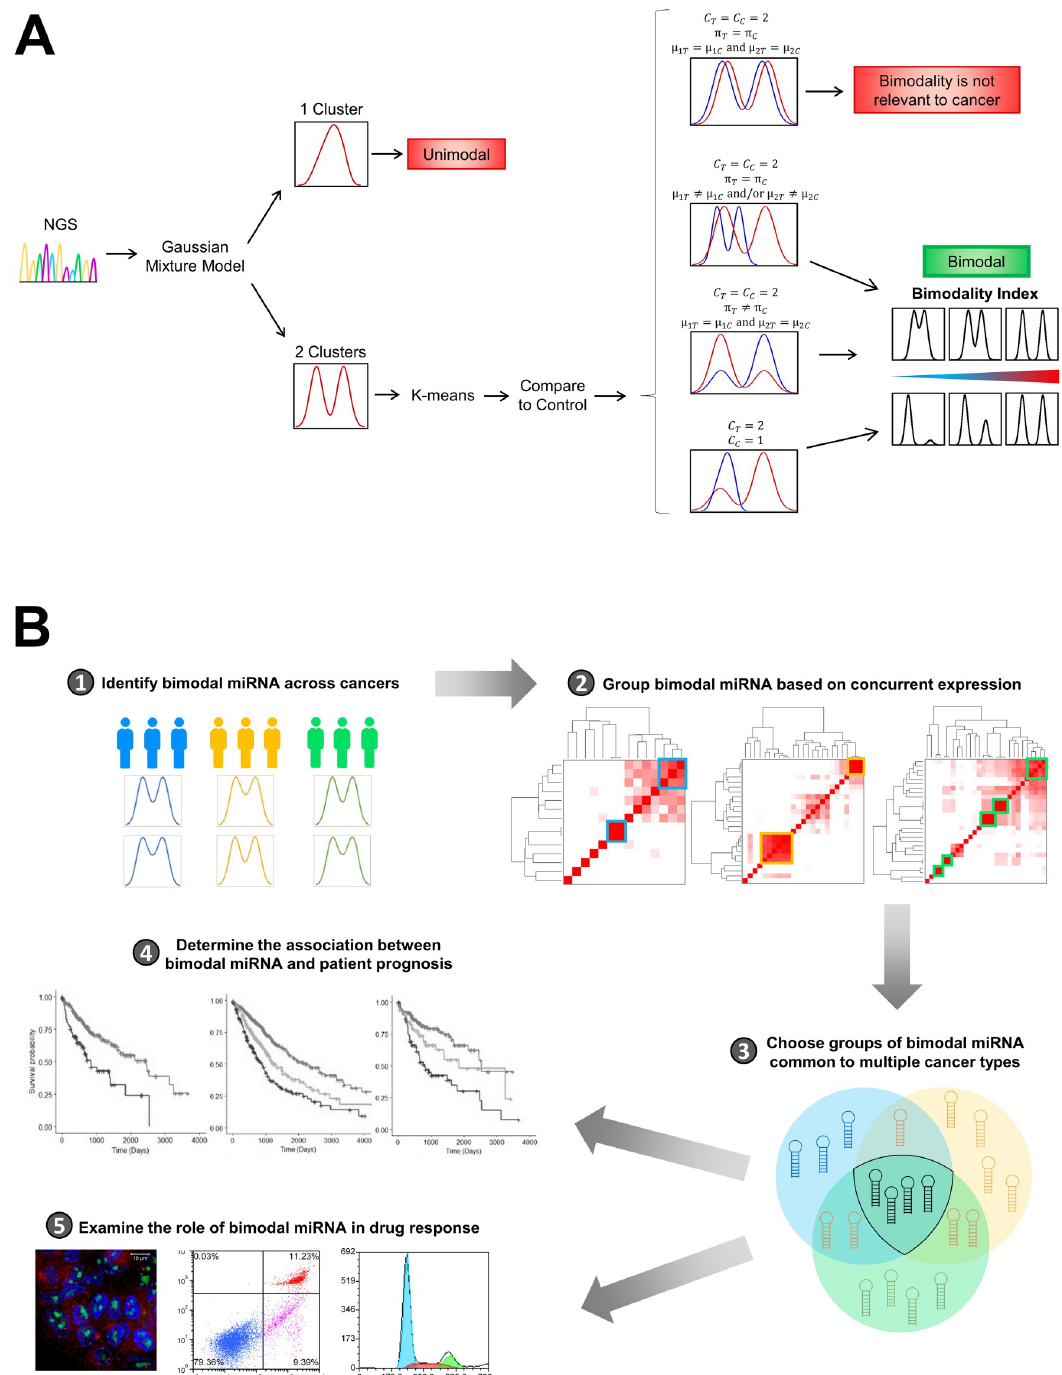
Fig 1. Strategies for identification of bimodal miRNA and evaluation of their clinical relevance. (A) Controlled mixture modeling (CM) was employed to identify bimodal miRNA. Gaussian mixture modeling was performed to identify one- and two- component miRNA. The distributions of two-component miRNA were then compared to control tissue before calculation of the bimodality index. (B) To assess the clinical relevance of bimodal miRNA, CM was used to identify bimodal miRNA across nine cancer types. Groups of concurrently expressed miRNA that were common to multiple cancer types were then further investigated for their role in patient prognosis and drug response.